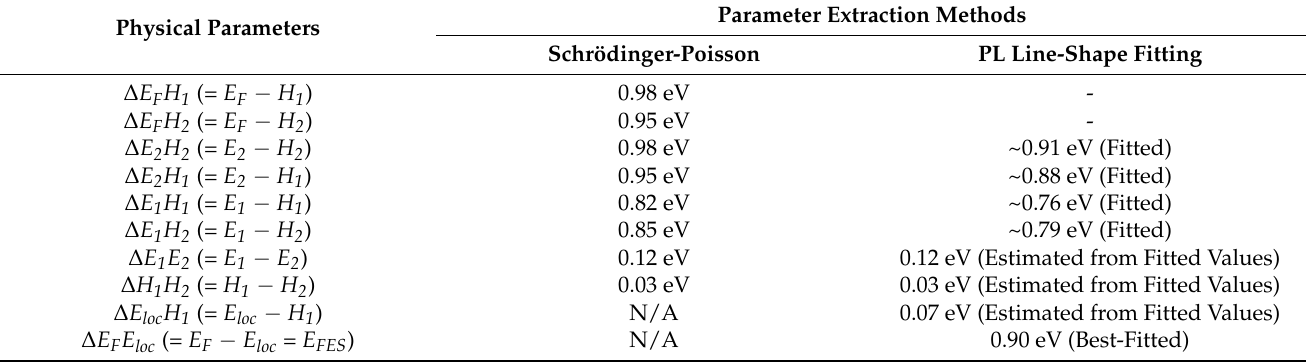
Table 1. Comparison of the physical parameters between the calculated (i.e., Schrödinger-Poisson equation) and the fitted values (i.e., localization energy-included line shape